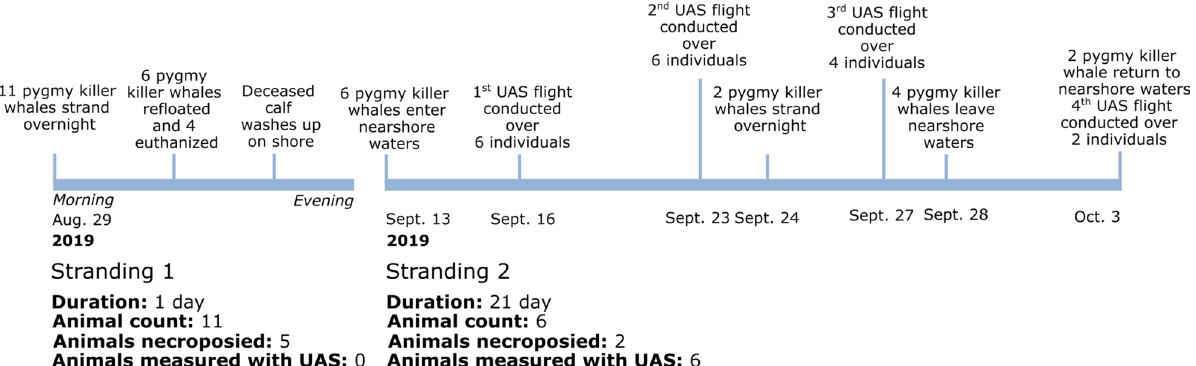
Figure 1. The timeline of two stranding events managed by NOAA Fisheries involving 17 pygmy killer whales (Feresa attenuata) that took place in the nearshore waters of Ma ʻ alaea Bay, Maui between August and October